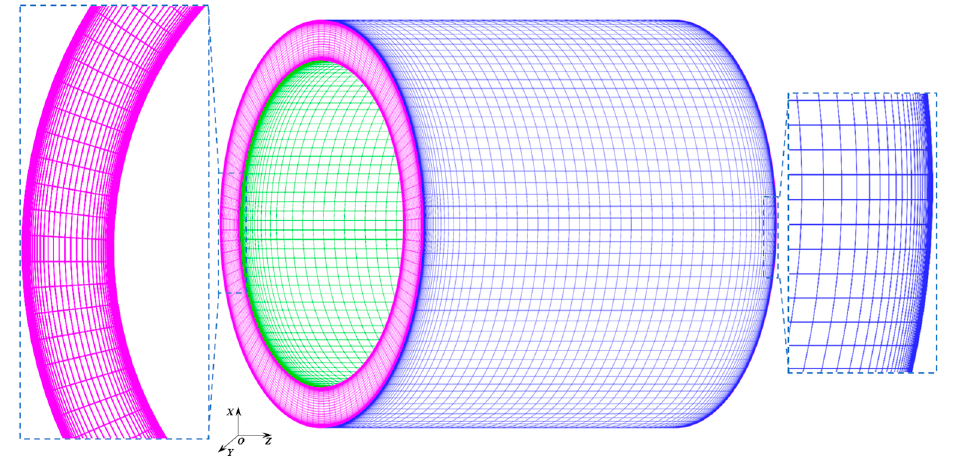
Figure 5. Structured mesh of computational domain and its partially enlarged detail.